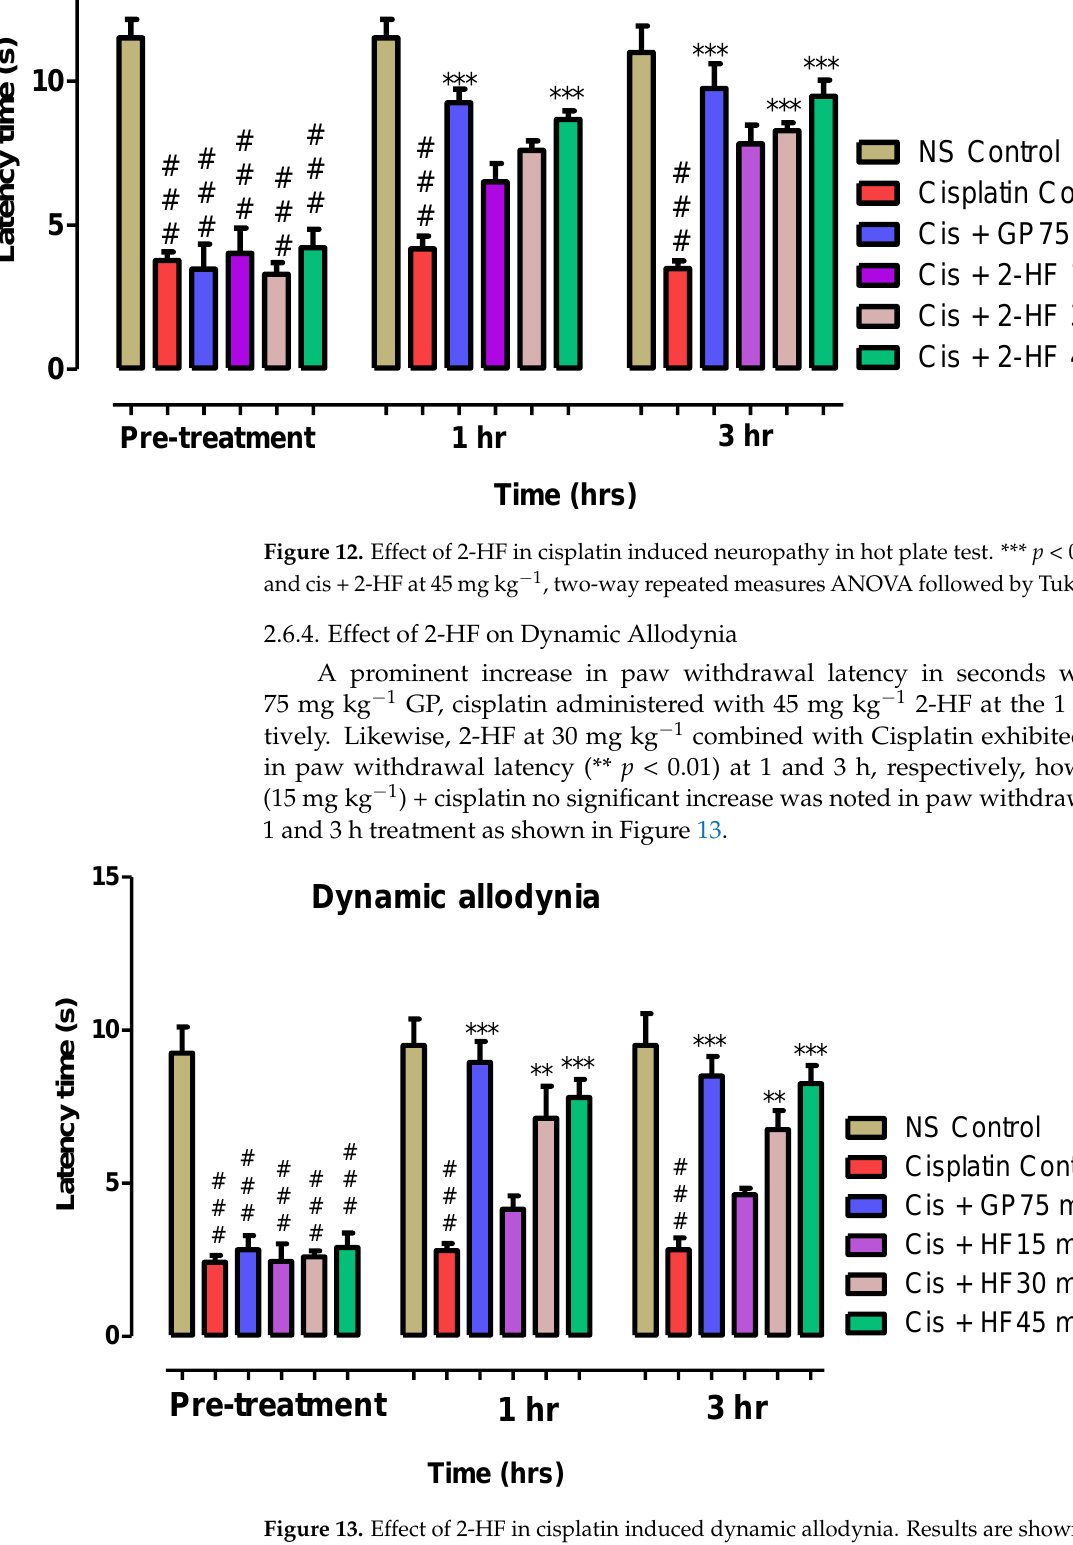
Figure 13. Effect of 2-HF in cisplatin induced dynamic allodynia. Results are shown in mean ± SEM ( n = 6). There is a significant increase for cisplatin + 2-HF 45 mg kg − 1 (*** p < 0.001, ** p < 0.01, * p < 0.05), comparable to that of the standard control cisplatin + GP (*** p < 0.001), using two-way repeated measures ANOVA followed by Tukey’s post hoc test. Each bar shows mean ± SEM.